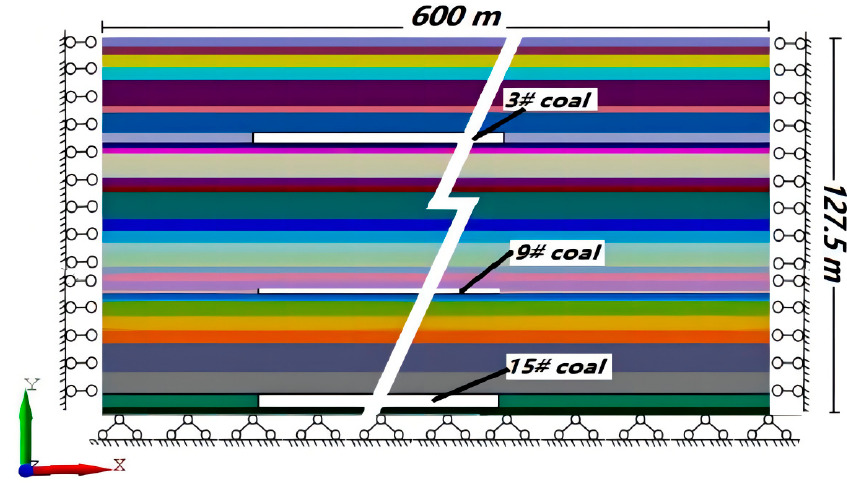
Figure 4. Schematic of model size and boundary conditions.